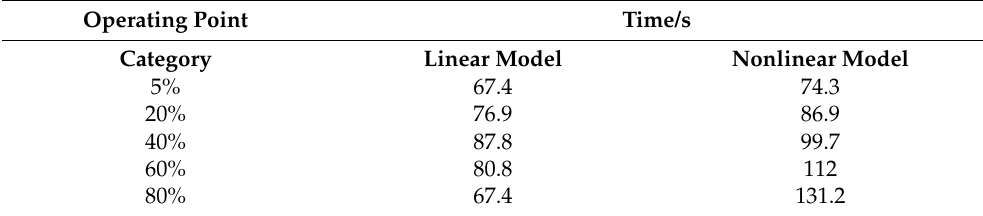
Table 3. Time for the system to reach the equilibrium point in the process of load